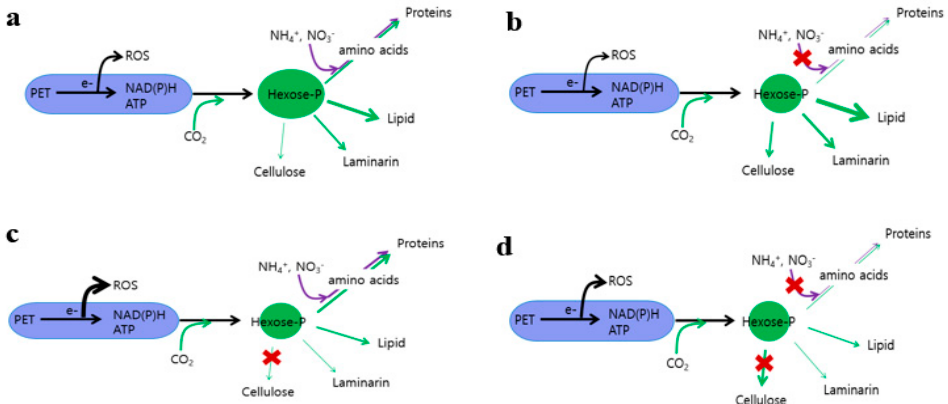
Figure 6. Seesaw model for hexose-P partitioning between C and N polymers in N. salina . Partitioning of photosynthetically fixed C into the C and N pathways under normal growth conditions ( a ) is subject to a reciprocal change when one of the pathways is impaired by either nutrient deprivation ( b ) or mutation ( c ). Under N-deficiency conditions, increased conversion of photosynthate assimilates into both storage and structural C polymers, driven by changes in specific gene expression on the transcriptional level, causing reciprocal changes in the protein and C polymer contents ( b ). Genetic impairment of hexose-P partitioning into cellulose biosynthesis appears to favor accumulation of soluble protein rather than storage carbohydrates ( c ). In addition to photochemical reaction, N. salina adopts a nonradiative dissipation pathway via reactive oxygen species (ROS), which becomes evident when the availability of the C pathway is reduced ( c ). Simultaneous impairment of the two C and N pathways would involve alternative, but unknown, ROS-independent outlets ( d ).